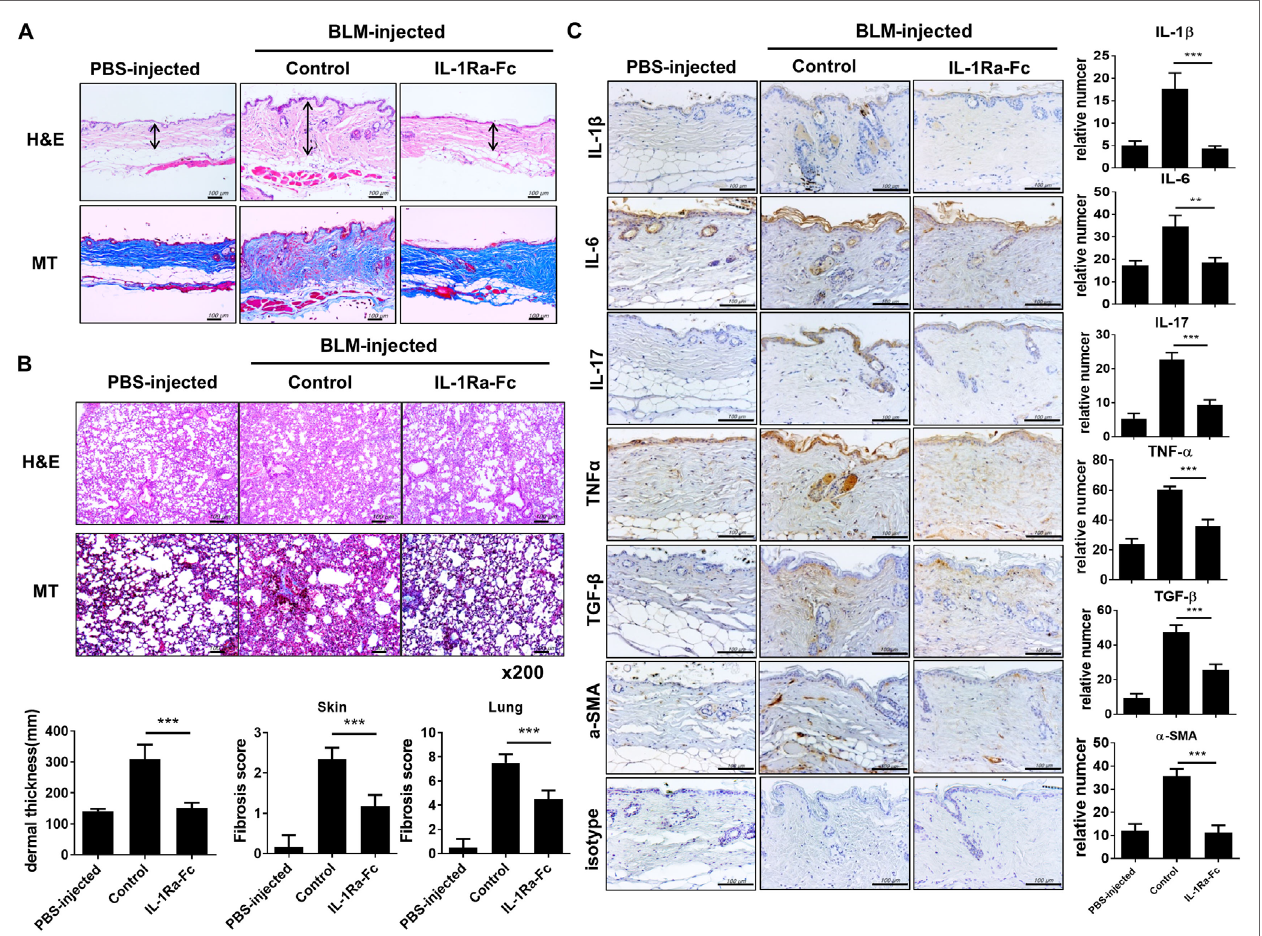
FigUre 5 | Antifibrotic effects of IL-1 receptor antagonist in the bleomycin (BLM)-induced fibrosis model. (a,B) C57BL/6 mice received a daily injection of phosphate-buffered saline or BLM for 28 days ( n = 5/group). The mice with BLM-injected fibrosis were divided into a group that received the IL-1 receptor antagonist (anakinra) and a group that did not receive anakinra ( n = 5/group). Anakinra (100 mg/kg) was injected intraperitoneally three times per week for 2 weeks (from day 15 to day 28) after the start of BLM injection. Representative sections stained with hematoxylin and eosin and Masson’s trichrome (MT) in skin (a) and lung (B) show the reduced dermal thickness [arrows in (a) ] and attenuated skin and lung fibrosis following anakinra. Scale bar represents 100 µm (skin) and original magnification 200 × (lung). Quantification of dermal thickness in affected skin and fibrosis score of skin and lung are shown in bar graphs as the mean ± SEM for five independent experiments per group. *** p < 0.001. (c) Immunohistochemical staining for the frequency of IL-1 β -, IL-6-, IL-17-, TNF- α -, TGF- β -, and α -SMA-positive cells in lesional skin. Left panel; positive immunoreactivity appears as a brown color. Scale bar represents 100 µm. Right panel; the data are expressed as the mean ± SEM for three independent experiments per group. Scale bar represents 100 µm. ** p < 0.01, *** p <